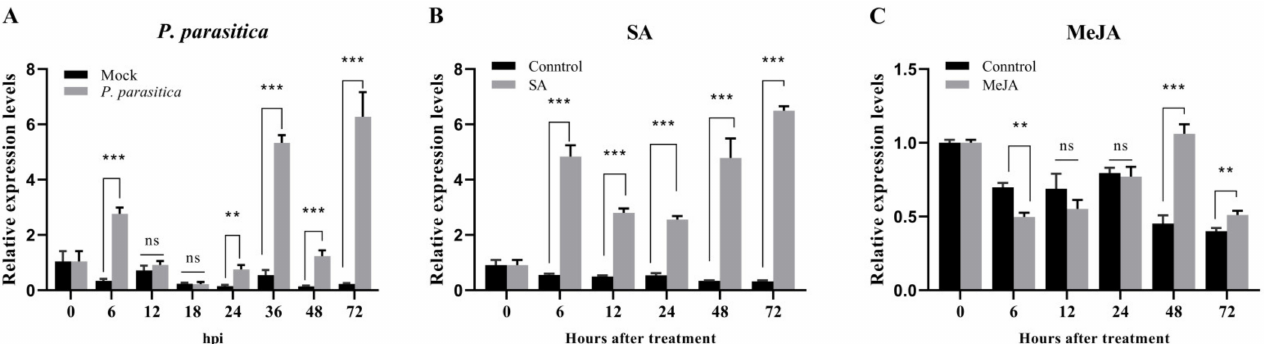
Figure 3. Transcript levels of NpFBA1 under treatment with P. parasitica , SA and MeJA. ( A ) Transcript levels of NpFBA1 under treatment with P. parasitica . ( B ) Transcript levels of NpFBA1 under treatment with SA. ( C ) Transcript levels of NpFBA1 under treatment with MeJA. Asterisks denote significant differences (compared with the control group): ** p < 0.01, *** p < 0.001, by Student’s t -test; ns, no significant difference; number of samples, n =